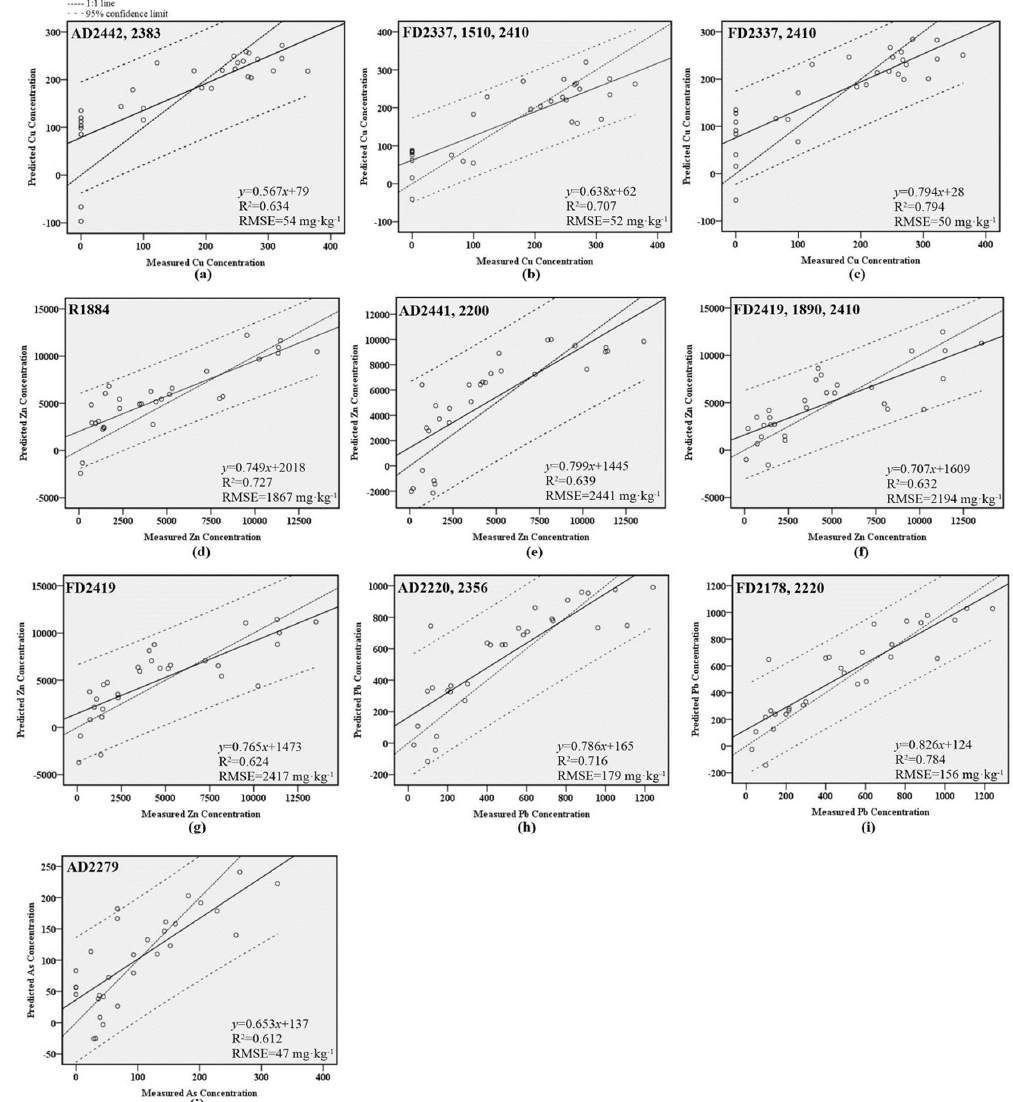
Figure 8. Comparison between the measured heavy metal concentration in experiments and predicted heavy metal concentration derived from regression models of Group A. ( a ) Validation model at absorption depth of 2442, 2383 nm for Cu concentration; ( b ) validation model at first derivatives of 2337, 1510, 2410 nm for Cu concentration; ( c ) validation model at first derivatives of 2337, 2410 nm for Cu concentration; ( d ) validation model at reflectance of 1884 nm for Zn concentration; ( e ) validation model at absorption depth of 2441, 2200 nm for Zn concentration, ( f ) validation model at first derivatives of 2419, 1890, 2410 nm of Zn concentration; ( g ) validation model at first derivatives of 2419 nm for Zn concentration; ( h ) validation model at absorption depth of 2220, 2356 nm for Pb concentration; ( i ) validation model at first derivatives of 2178, 2220 nm for Pb concentration, and ( j ) validation model at absorption depth of 2279 nm for As concentration.